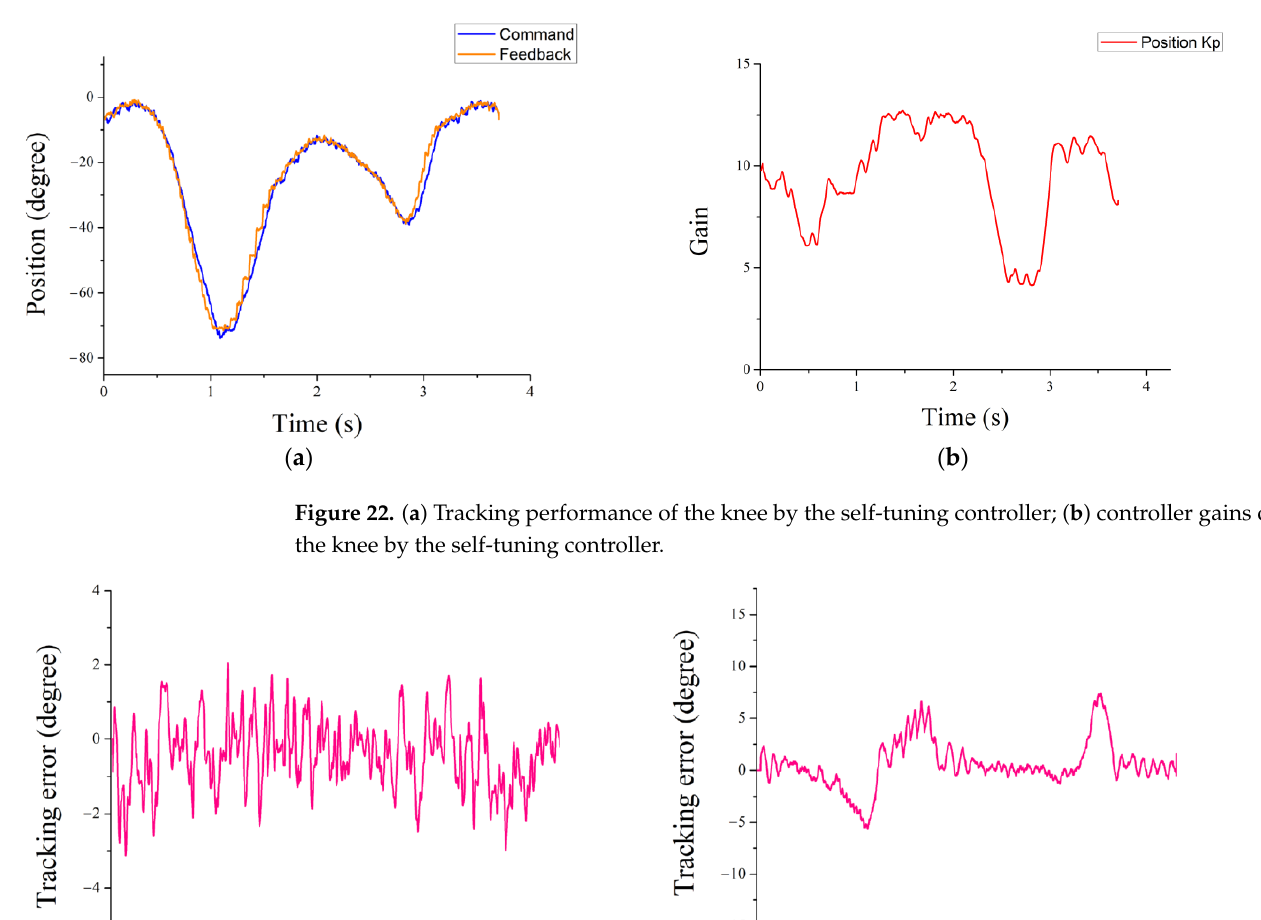
Figure 21. ( a ) Tracking performance of the hip by the self-tuning controller; ( b ) controller gains of the hip by the self-tuning controller.